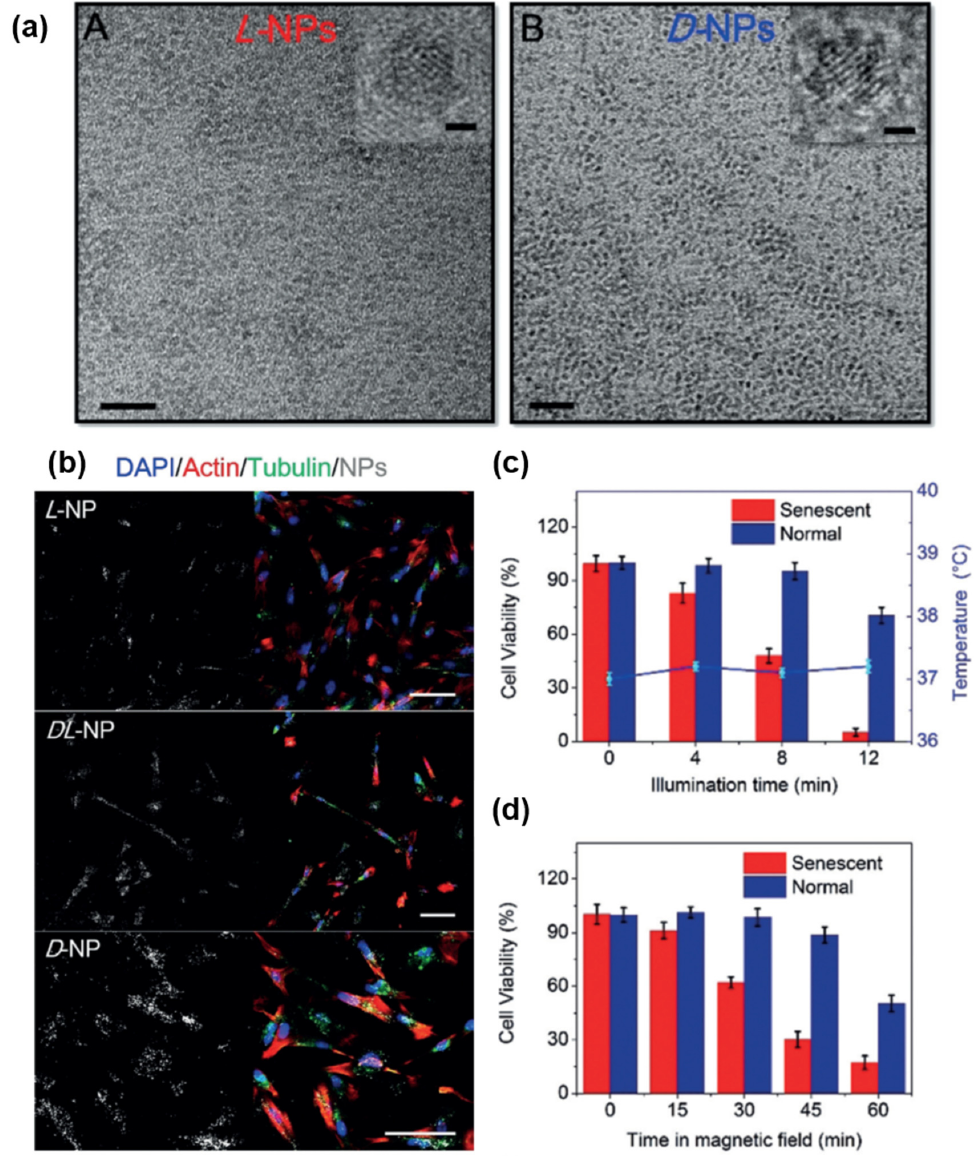
Figure 3. ( a ) TEM images of (A) L- and (B) D- penicillamine stabilized Cu x Co y S NPs, scale bar = 20 nm. The upper-right images are high-resolution images of corresponding NPs, scale bar = 1 nm. ( b ) Confocal images of L- , DL- and D- NPs in senescent cells, scale bar = 100 μ m. ( c ) Cell viability of D- NP internalized senescent cells with different NIR illumination times. ( d ) Cell viability of D- NP internalized senescent cells after being treated with AMF at different time points. Reprinted with permission from Ref. [20]. Copyright 2020 John Wiley and